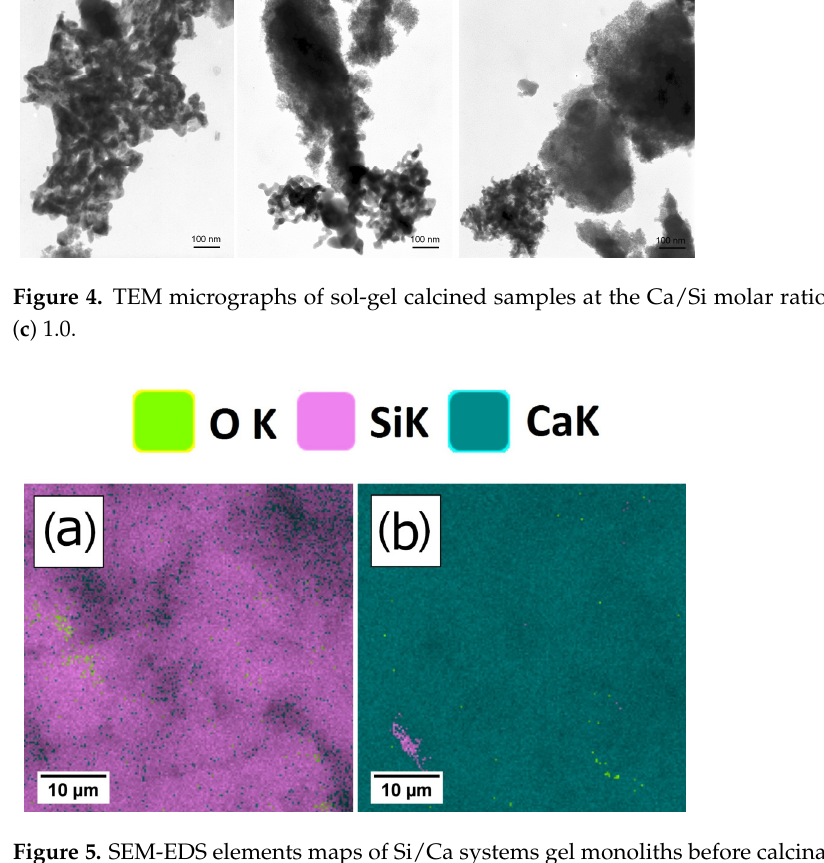
Figure 4. TEM micrographs of sol-gel calcined samples at the Ca/Si molar ratio: ( a ) 0.25; ( b ) 0.5; ( c ) 1.0.